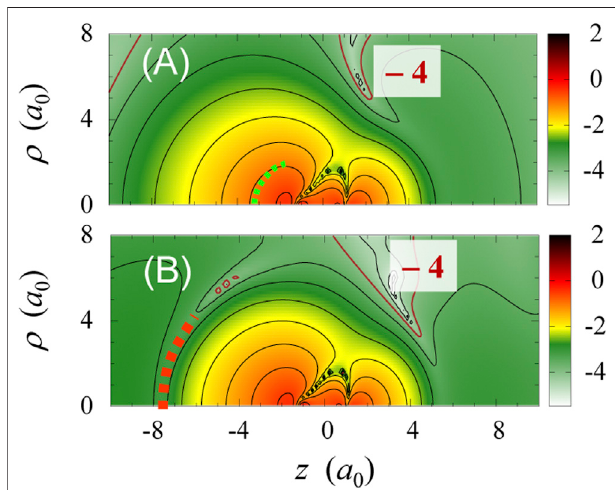
FIGURE 6 | 2D contour plots of ϕ 5 σ ( t ) for four-color fi elds: (A) (cid:1)(cid:1)(cid:1)(cid:1) (cid:1)(cid:1)(cid:1)(cid:1) ( t ) ϕ log 10 at t ≈ 2.8 fs for the pulse in Figure 3C ; (B) log 10 5 σ fs for the pulse in Figure 3D . The brown line represents the height of (cid:1)(cid:1)(cid:1)(cid:1) (cid:1)(cid:1)(cid:1)(cid:1) ( t ) (cid:2) 10 − 4 a − 3 / 2 ϕ 5 σ 0 . The contour interval on the logarithmic scale is 0.5. Thelightgreendottedlinein (A) denotesthehumpridgelinein Figure 5A .The red dotted line in (B) denotes the valley in υ eff 5 σ ( t ) for Figure 4D , along which a groove runs in the contour map of log 10